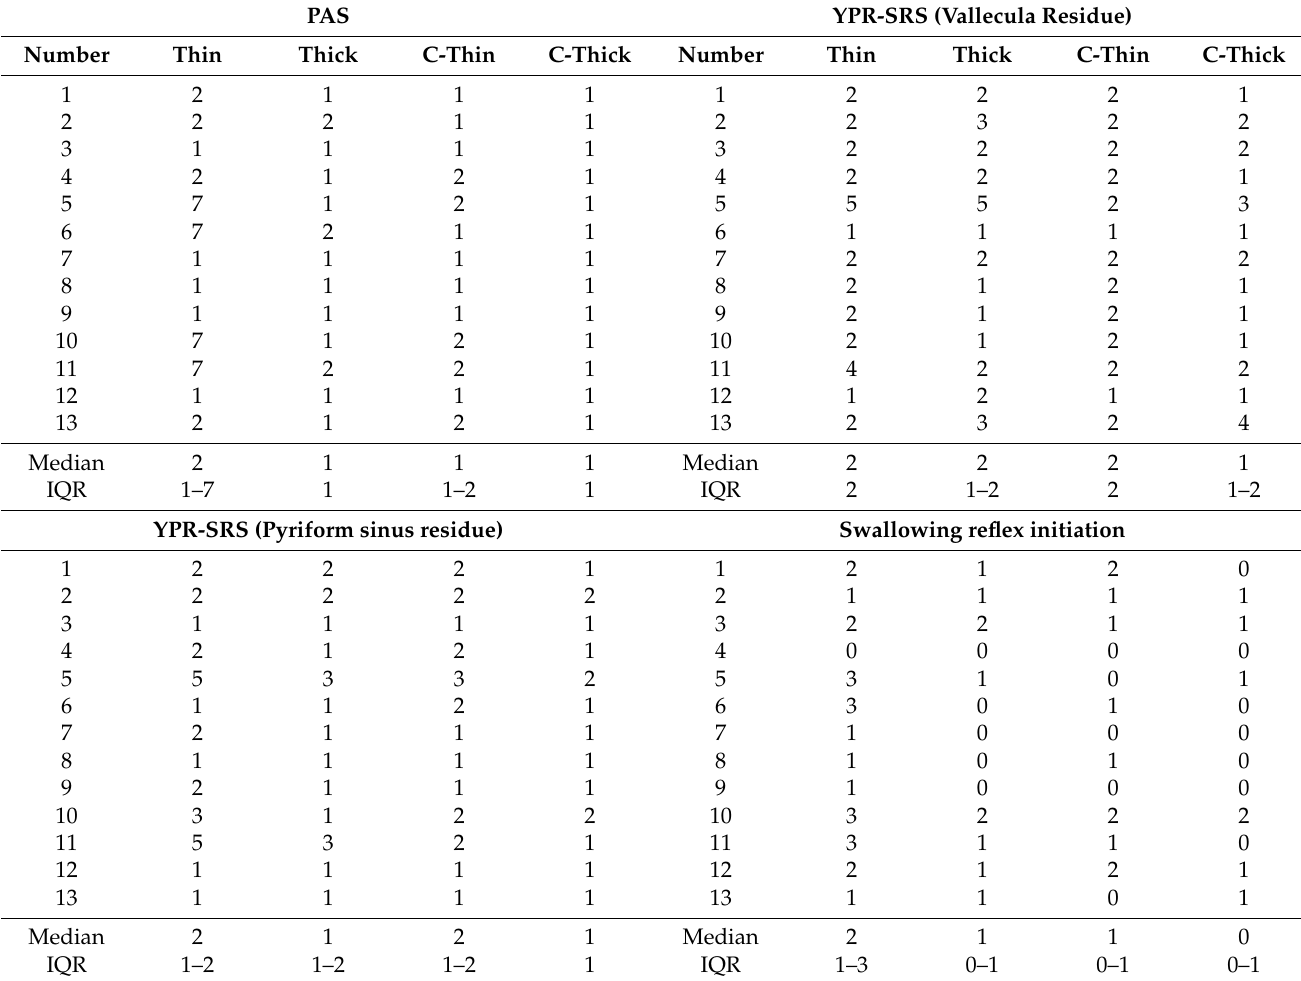
Table 2. Differences by liquid for each